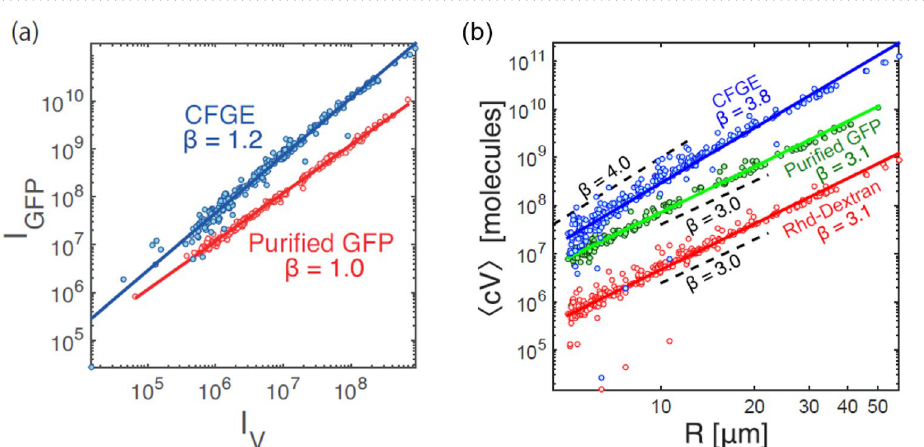
Figure 3. ( a ) deGFP expressed from TXTL extract (N = 246) and purified deGFP (control, N = 191) in each droplet. The horizontal axis represents the droplet size by using fluorescent marker (Rhodamine-Dextran). ( b ) Log-log plots of the total intensity along droplet radius. Blue circles denote deGFP intensity resulting from CFGE in emulsion droplets. Green circles and red circles are the intensity of purified deGFP and marker protein,